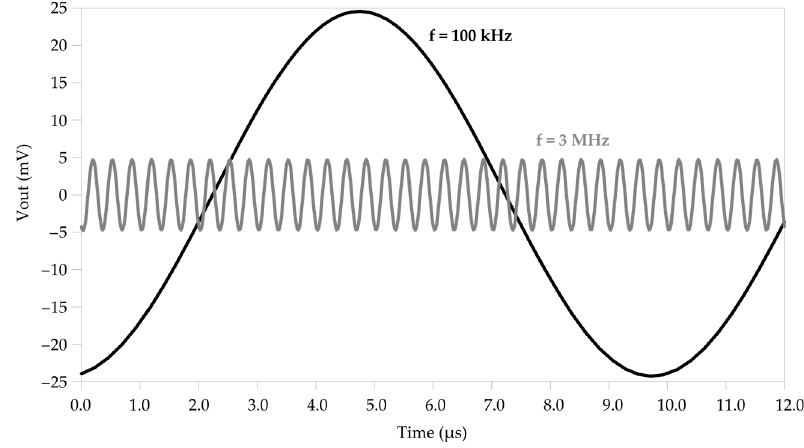
Figure 10. Time domain output for the low-pass configuration.